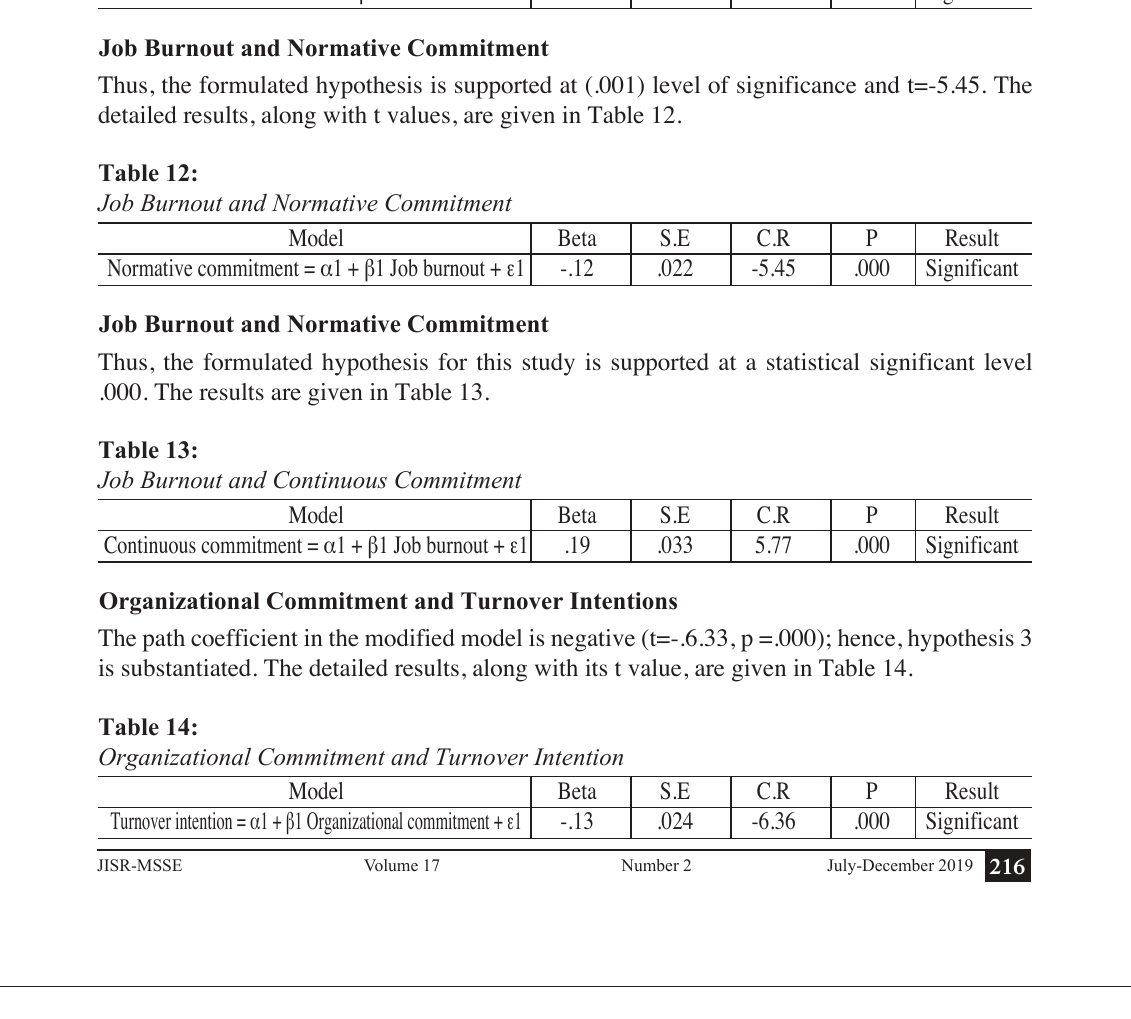
Job Burnout and Affective Commitment